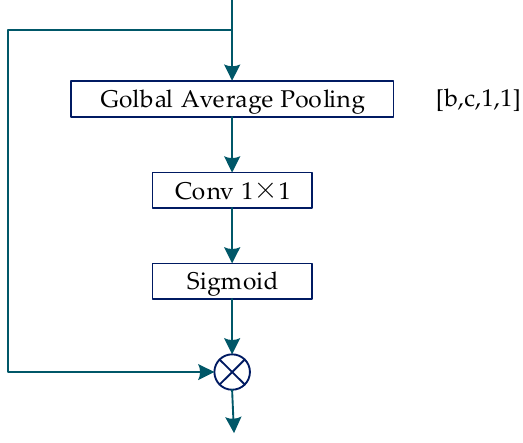
Figure 9. Channel attention.